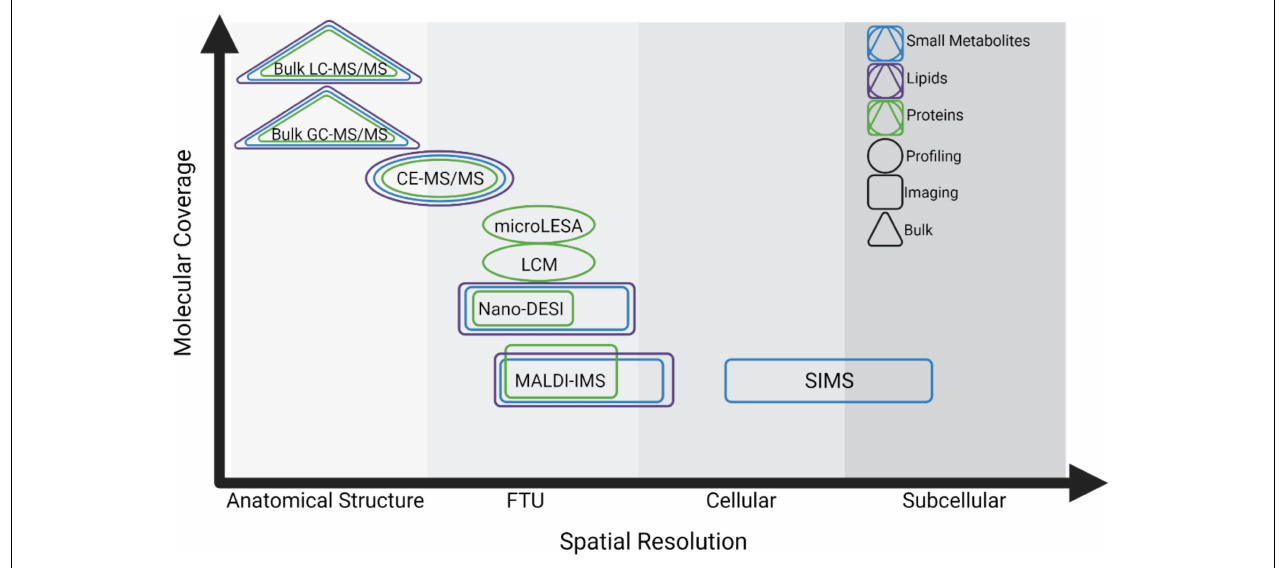
FIGURE 1 | Summary of spatial MS technologies and the trade-offs between spatial resolution and molecular coverage. Technologies are characterized based on their spatial resolution from the level of anatomical structure ( > 500 µ m), Functional Tissue Unit (FTU, ∼ 50–500 µ m), cellular ( ∼ 10–50 µ m), and subcellular ( < 10 µ m). Triangles indicate technologies for analysis of bulk or homogenate tissues, circles indicate profiling experiments, and rectangles indicate imaging experiments. Methods for analyzing small metabolites, lipids, and proteins are shown in blue, purple, and green,